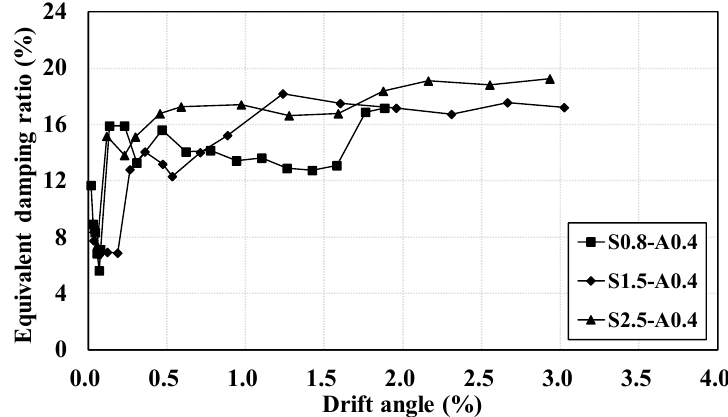
Figure 12. Equivalent damping ratio.